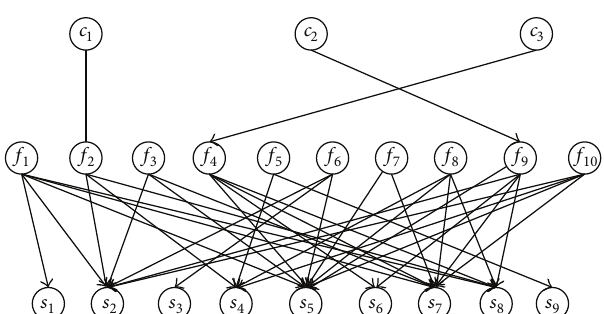
Figure 4: The integrated diagnosis model in our previous research work [15].